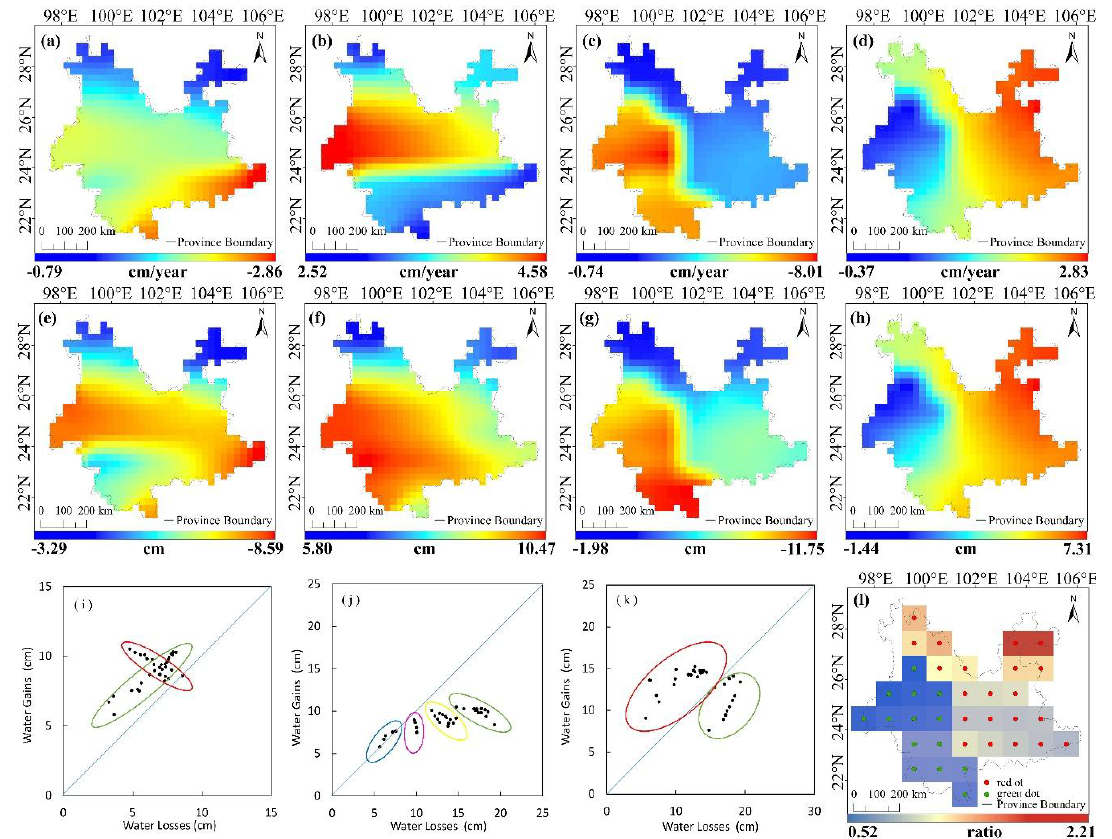
Figure 5. Spatial distribution of Total Water Storage Anomalies trends during ( a ) Segment 1; ( b ) Segment 2; ( c ) Segment 3; and ( d ) Segment 4; spatial distribution of total water storage changes during ( e ) Segment 1; ( f ) Segment 2; ( g ) Segment 3; and ( h ) Segment 4; scatterplot of total water gains vs water losses during ( i ) Segments 1 and 2; ( j ) Segments 1, 2, and 3; and ( k ) Segments 1, 2, 3, and 4; ( l ) spatial distribution of the ratio of total water gains to losses during the study period. The red dots correspond to the points clustered in the red circle in ( k ), and the green dots correspond to the points clustered in the green circle in ( k ) of Yunnan province.